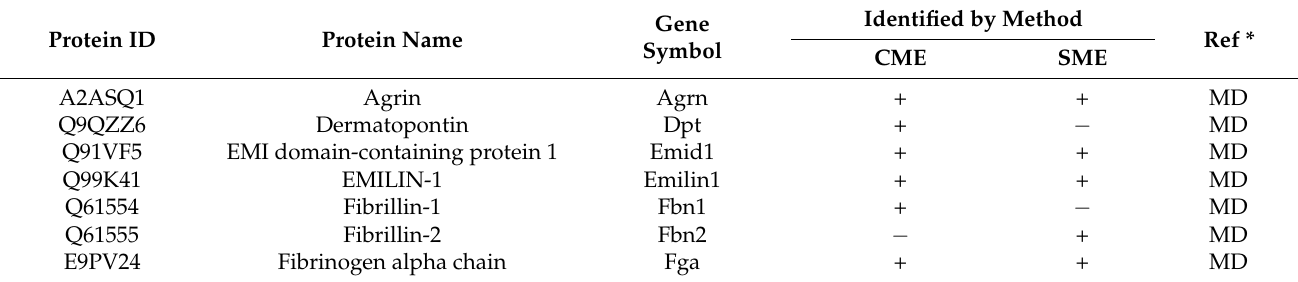
Table A2. The list of core matrisome proteins belonging to the category of glycoproteins and identified in at least two of the biological replicates. A row highlighted in yellow describes an identified matrisome protein which was not previously listed in the